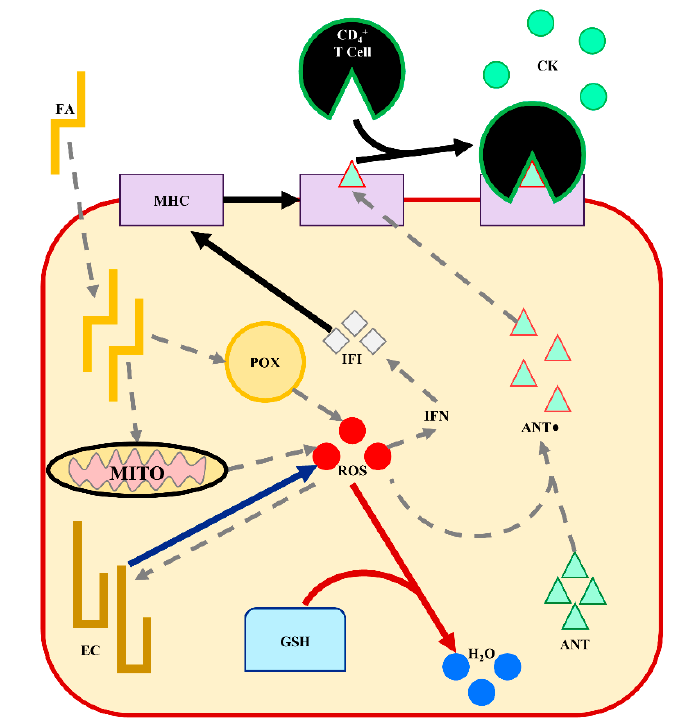
Figure 5. A working model of differentially regulated metabolic pathways in the liver of dairy cows that contribute to the pathology of lipid-related metabolic disorders. Fatty acids (FA) entering the hepatocyte are oxidized in the mitochondria (MITO) and peroxisomes (POX), producing energy and reactive oxygen species (ROS). Interferon (IFN) production is promoted by ROS, stimulating major histocompatibility complex (MHC) expression. Antigens (ANT) are oxidized (ANT ● ) by ROS. The ANT ● are presented by the MHC promoting CD4+ T lymphocyte recruitment and cytokine (CK) production. Eicosanoids (EC) are formed by FA oxidation by ROS, and may promote ROS production. Glutathione (GSH) reduces ROS and other oxidized products. Arrows demonstrate the directionality and specificity of metabolic pathways: pathways not differentially regulated are grey dashed lines (----), pathways upregulated in cows less resistant to LRMD are blue ( ⸺⸺ ), pathways upregulated in cows less susceptible to LRMD are red ( ⸺⸺ ), and pathways generally upregulated in cows less susceptible and less resistant are solid black ( ⸺⸺ ).